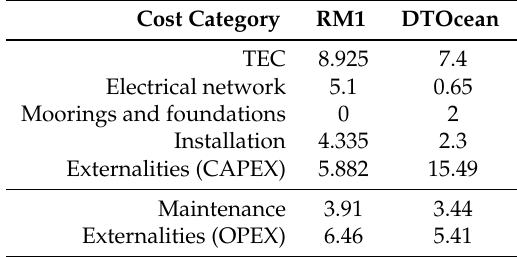
10 − 2 (cid:100) /kWh where 1 $ = ×